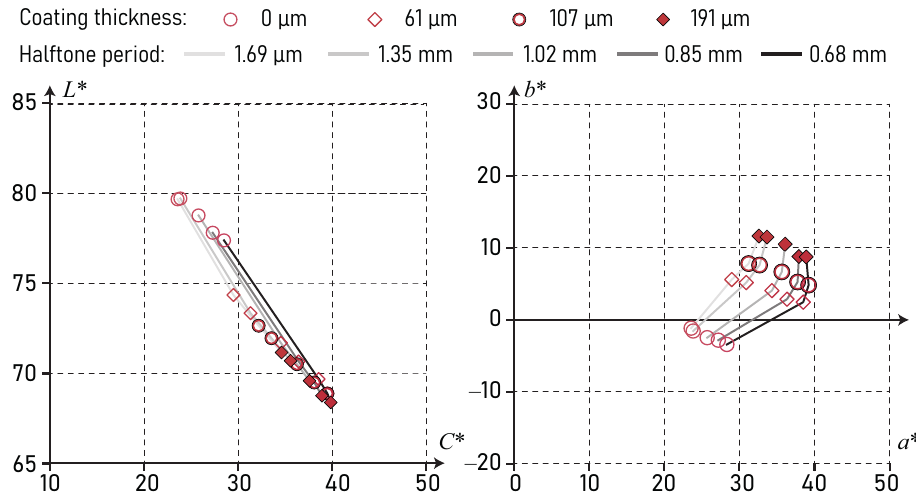
Figure 7. CIE1976 L*a*b* colorspace.